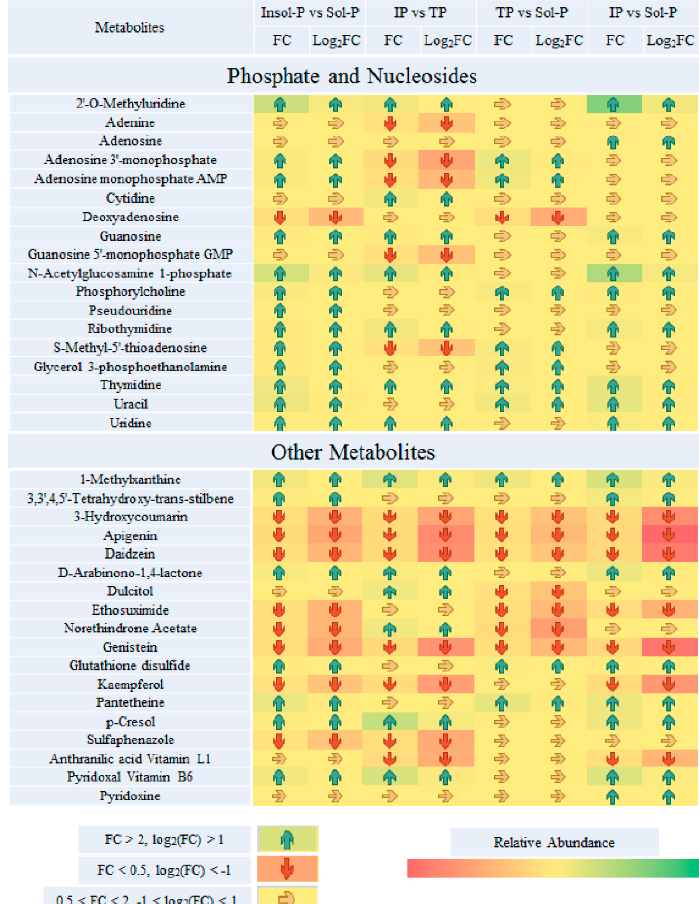
Figure 4. Paired fold change analysis of Important metabolites that are affected by P sources (insoluble P (Insol-P) and soluble P (Sol-P), tricalcium phosphate (TP) vs. iron phosphate (IP), TP vs. Sol-P and IP vs. Sol-P). TP refers to the tricalcium phosphate group; IP refers to the iron phosphate group; Insol-P refers to insoluble P, including TP and IP groups; Sol-P refers to soluble P (dipotassium phosphate) group. Arrows of average fold changes (FC) and log 2 (FC) are listed and painted with increased coded “blue” (FC > 2, log 2 (FC) > 1) and decreases coded “red” (FC < 0.5, log 2 (FC) < − 1) with significant changes ( p < 0.05). The color of arrow listed “yellow” represent the undetected metabolites or metabolites with no significant FC values changes (0.5 < FC < 2, p < 0.05).